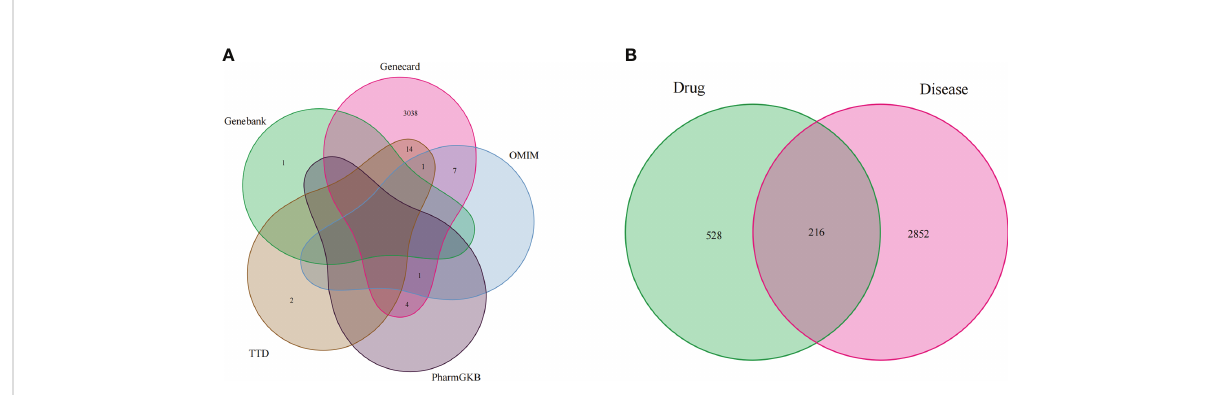
FIGURE 1 Venn diagram: (A) Venn diagram for GBM targets from databases; (B) RXLD-related GBM targets ’ Venn